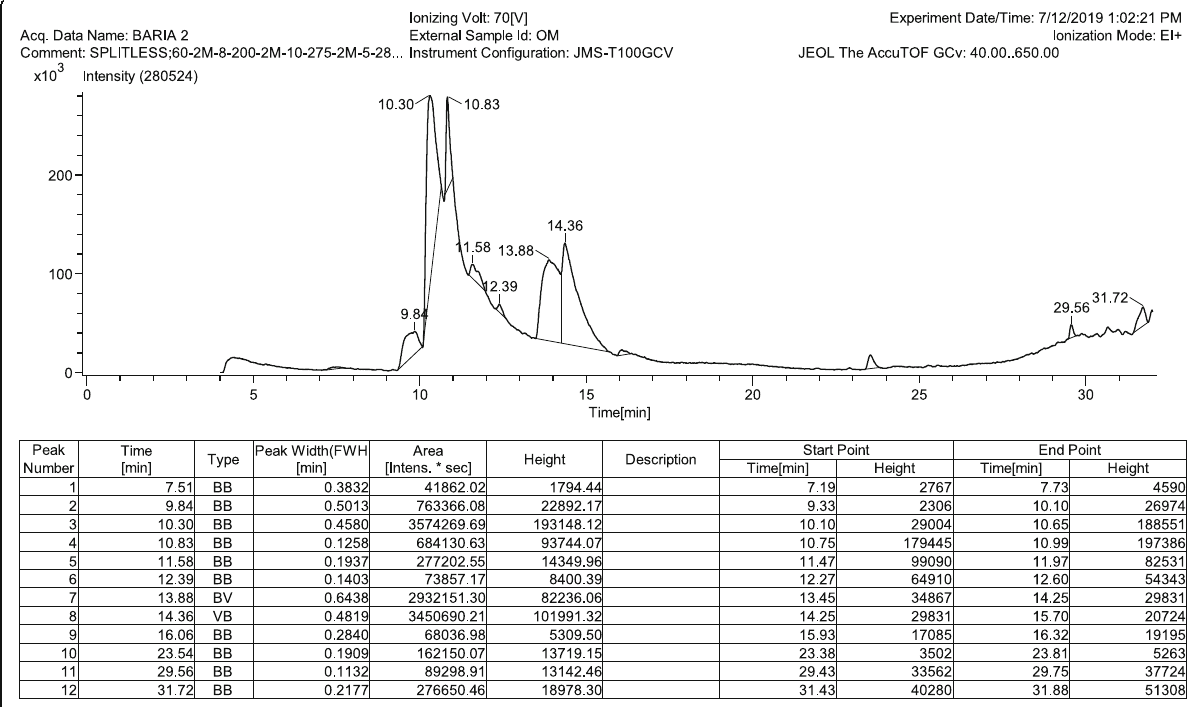
groups to block metabolically vulnerable methylene sites. And also they are stable and not prone to enzymatic attack. Oxetane improves the binding affinity of 1,25-dihydroxyvitamin D3 analogues for bovine thymus D3 receptors [17].